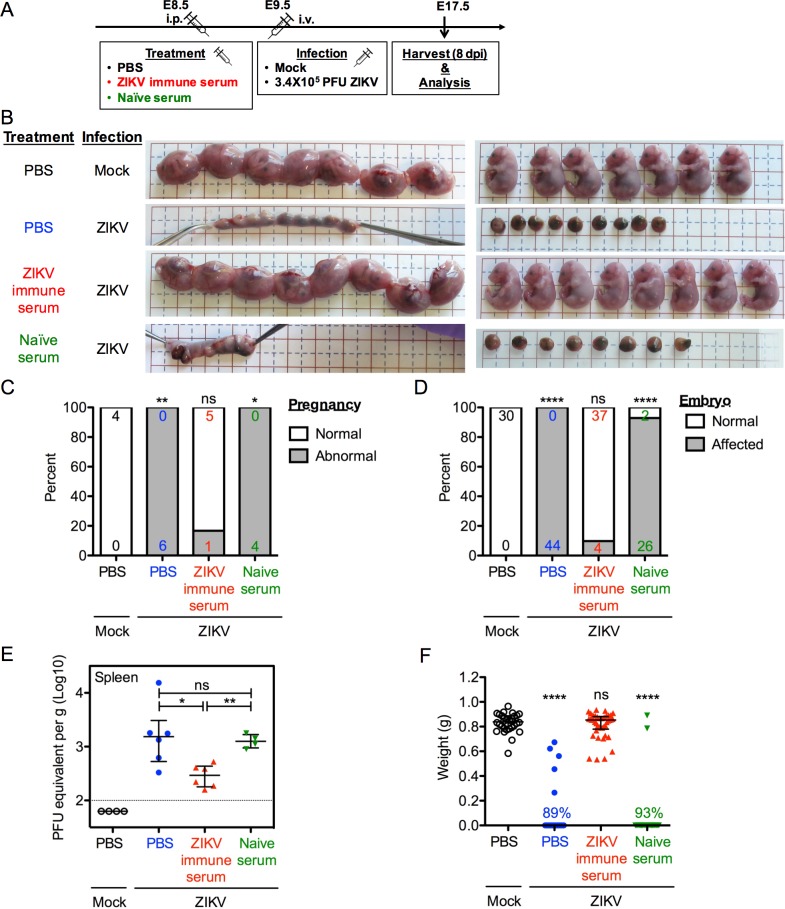
Convalescent immune serum transfer demonstrates the utility of fetal morphological outcome in assessing protective efficacy.Pregnant dams at E8.5 were treated intraperitoneally with PBS, 50 μL of serum from ZIKV-infected mice (ZIKV immune serum), or 250 μL of serum from naïve mice (naïve serum). Dams were infected at E9.5 with 3.4 × 105 PFU of ZIKV by intravenous route, and sacrificed 8 dpi at E17.5. Control mice were injected with Vero cell culture supernatant (Mock). (A) Scheme of infection. (B) Representative images of uteri and embryos or placental residues. (C and D) Impact of serum treatment on dams (C) or embryos (D), as described in Fig 1C. Numbers on bars indicate normal pregnancy/embryo (top) or abnormal pregnancy/affected embryo (bottom). (ns, not significant; * p<0.05; ** p<0.01; **** p<0.0001 compared with numbers in Mock group by Fisher’s exact test). (E) ZIKV RNA levels in the spleen of ZIKV-infected dams as measured by quantitative real-time PCR. Data shown are median with interquartile range. Dotted line depicts the limit of detection. (ns, not significant; * p<0.05; ** p<0.01 by Mann-Whitney test). (F) Embryonic weight. The percentage indicates the embryos that had undergone complete resorption. Data shown are median with interquartile range. (ns, not significant; **** p<0.0001 compared with Mock group by Mann-Whitney test). Data for all panels are one representative of 2 independent experiments with 4–6 pregnant dams in each group in each experiment.